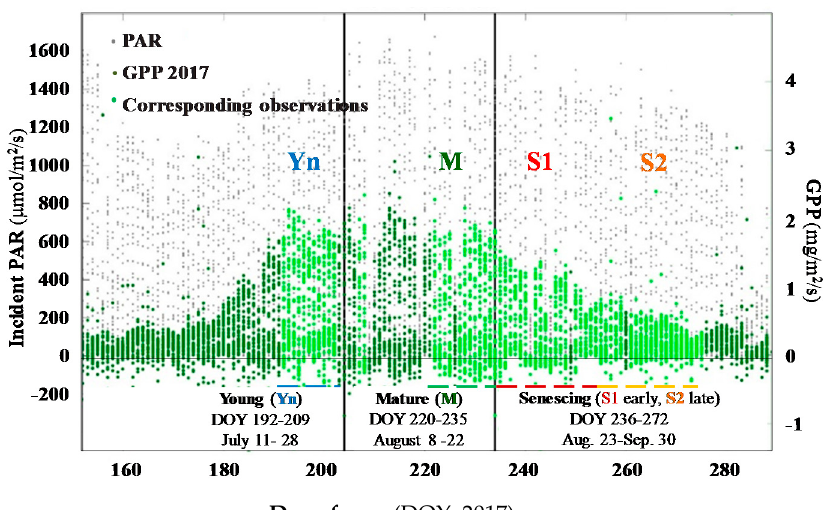
Figure 1. Eddy covariance measurements collected at OPE3, Greenbelt, MD in 2017, including incident photosynthetically active radiation (PAR, µmol/m 2 /s) and gross primary production (GPP, mg/m 2 /s)). The Y axes indicate the measured parameters. The days with corresponding MoniPAM and FLoX measurements are depicted in bright green. Days 192–209 demonstrate the dynamics in GPP during the corn young (Yn) growth stage, days 220–235 during the mature (M), and days 236–272 (S) during the senescing (S1 early and S2 advanced) growth stages.